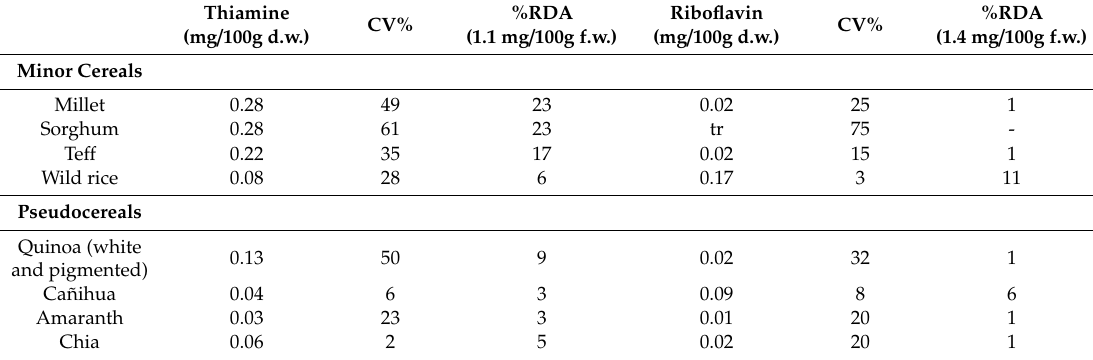
Table 5. Thiamine and riboflavin content in gluten-free grains (mg / 100g d.w.). Thiamine (mg / 100g